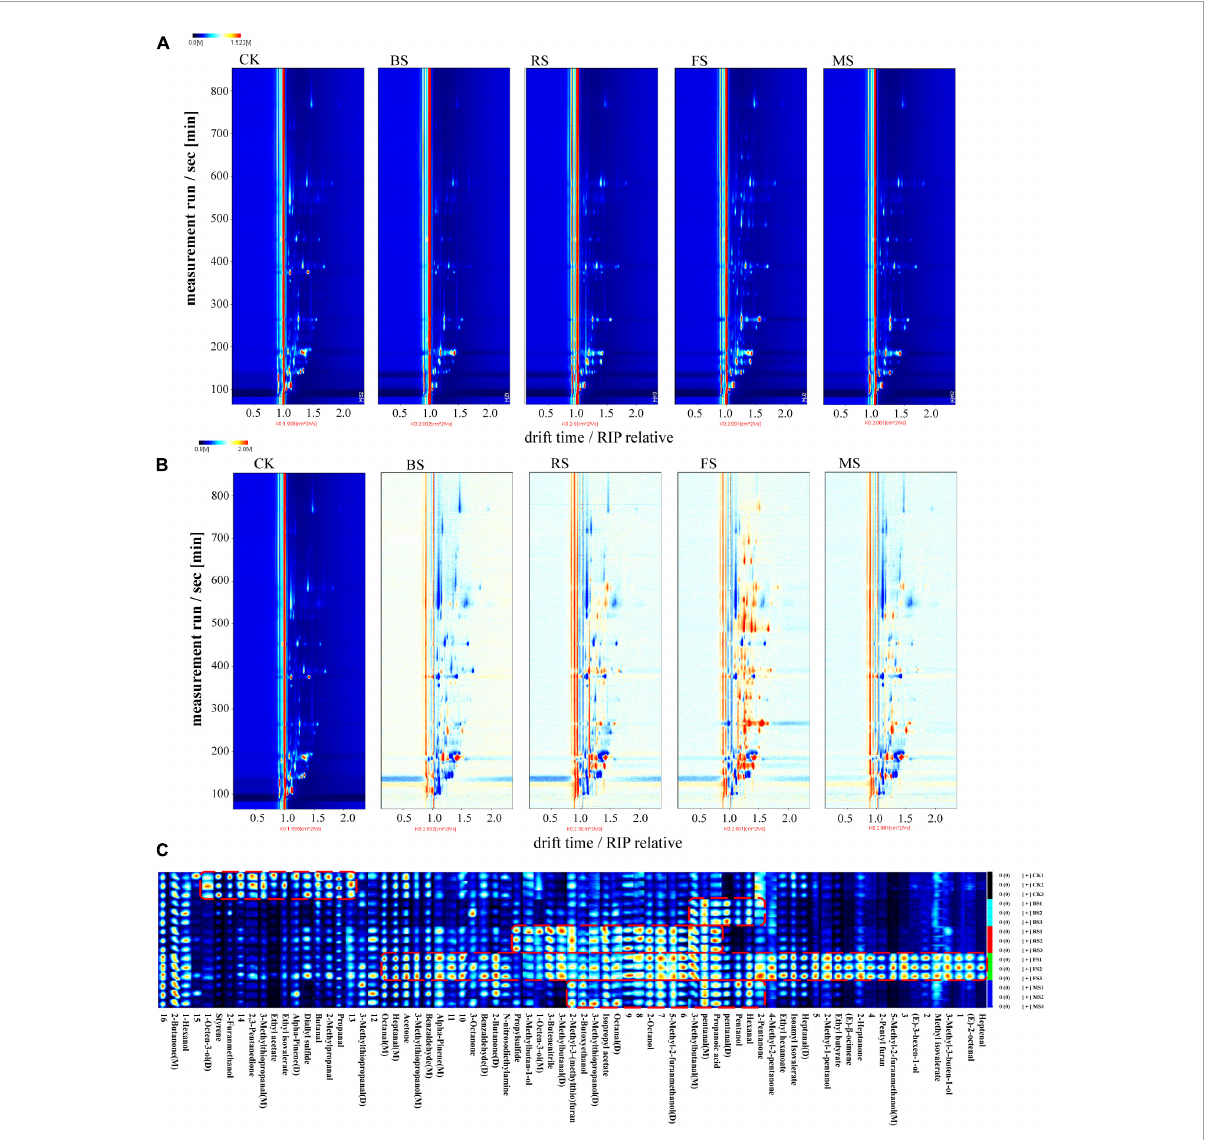
FIGURE1 Headspace-gas chromatography-ion mobility spectrometry (HS-GC-IMS) topographic plots and gallery plot of five treatment groups. (A) Topographic plot of HS-GC-IMS spectra; (B) Comparison of spectrogram results. (C) Gallery plot of five treatment groups. (M) and (D) denote monomer and dimer, respectively (CK, the control group; BS, boiled sample; RS, oven heated sample; FS, fried sample; MS, microwaved sample).